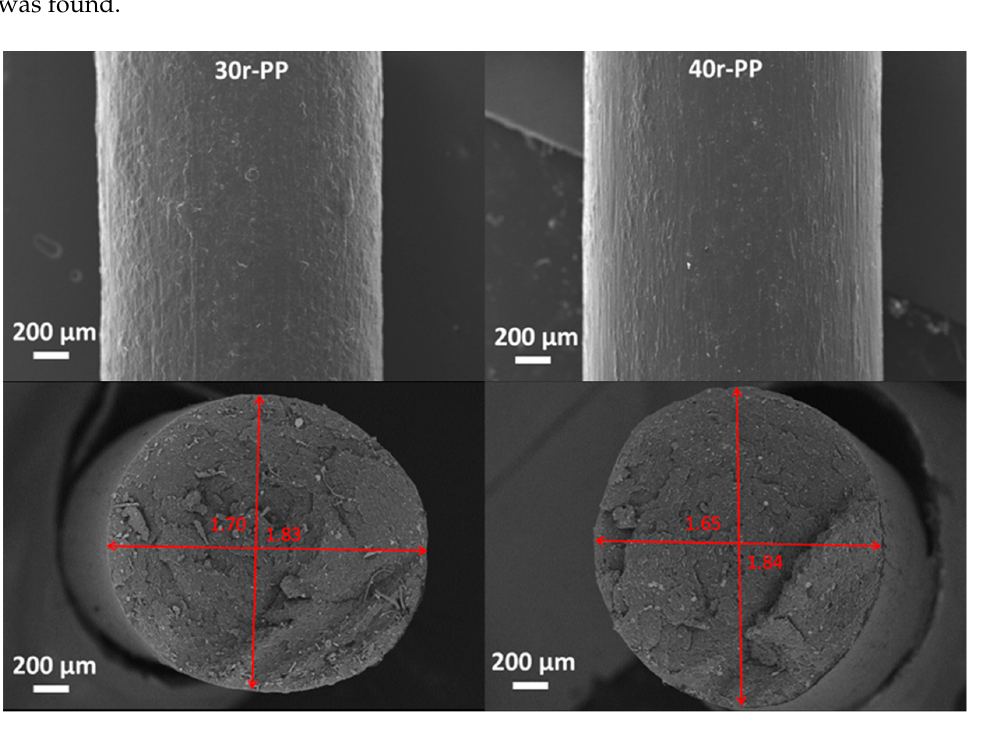
Figure 4. SEM micrographs of the filaments based on PPt/r-PP blends.